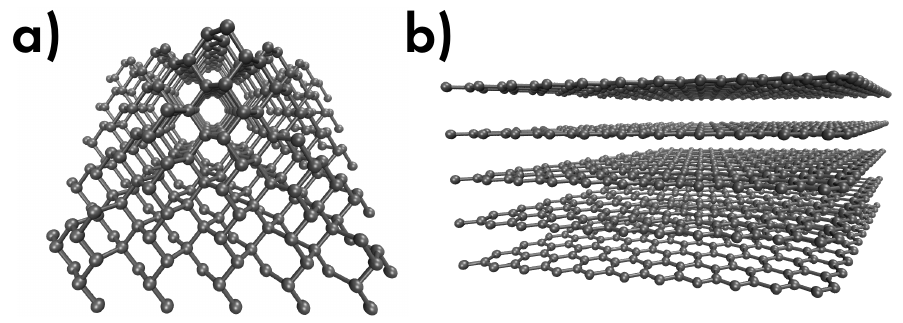
Figure 6. Exemplary ball and stick model of ( a ) diamond and ( b )